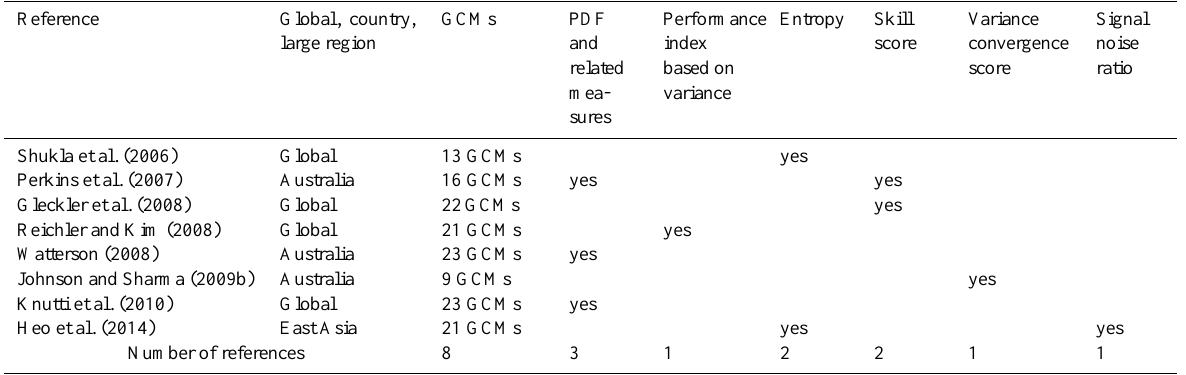
Table 2b. Ranking measures of performance assessment of CMIP3